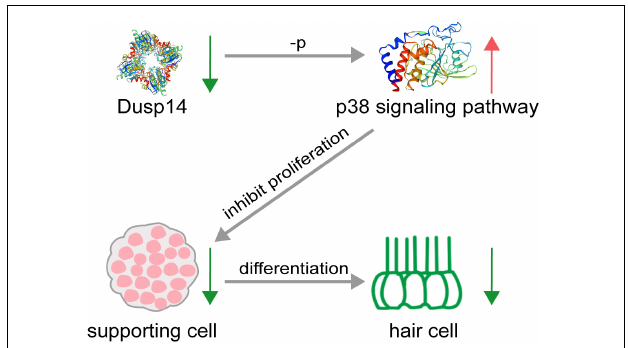
FIGURE 7 | Schematic diagram of hair cell reduction caused by dusp14 knockdown. Knockdown of dusp14 expression by morpholino inhibited the proliferation of supporting cells by p38 signaling pathway, resulting in a decrease in the number of hair cells and ultimately leading to abnormal hearing and balance-related behaviors in